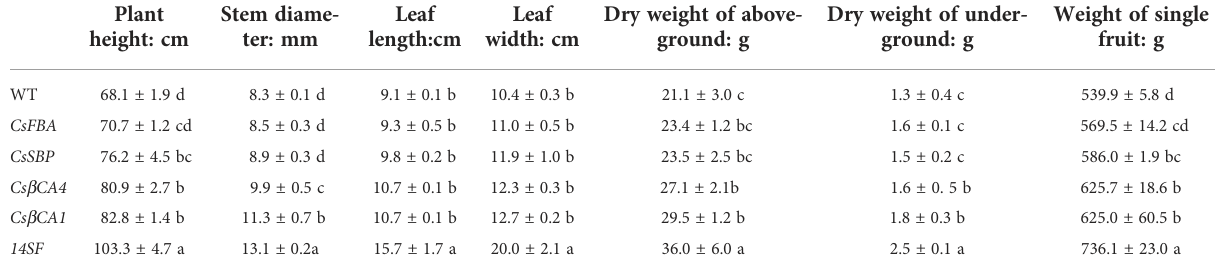
Dry weight of under- ground: g